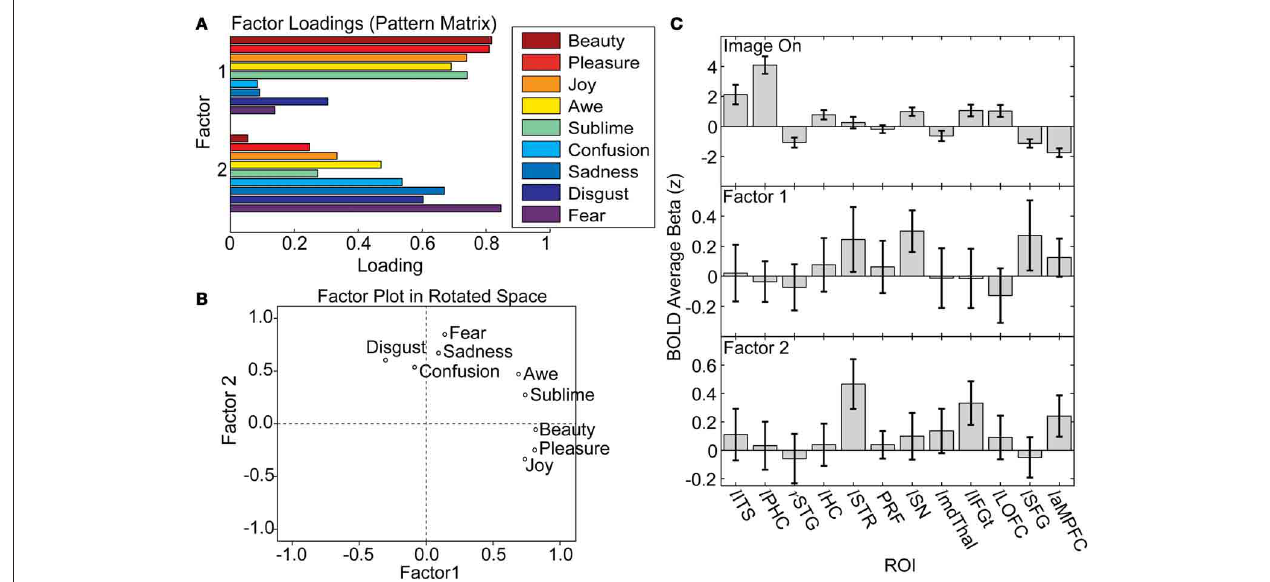
two clusters. (C) BOLD predictors constructed from factor scores reveal ROIs that respond to image onset or either factor. Responsivity to Factor 1 is significant in l SN and approaches significance in l STR and l SFG. Responsivity to Factor 2 is significant in l STR, l IFG and approaches significance in l aMPFC. Error bars are standard errors of the mean, computed across observers.